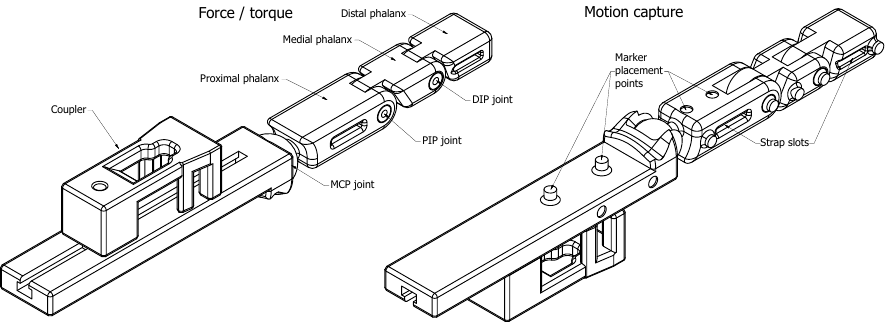
Figure 4. CAD drawings of dummy fingers for force and torque measurements (Left) and motion capture (Right). Dimensions for the fingers are presented in Table 4. The models are available online at the Thingiverse website